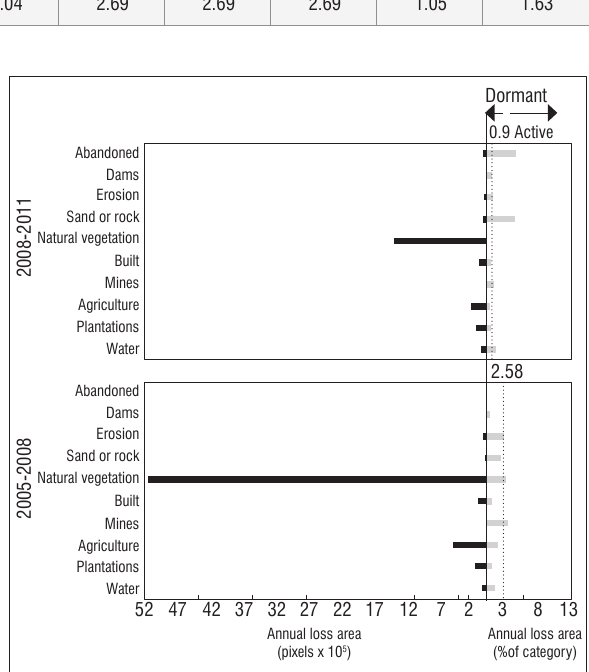
0.25 0.06 Dams 0.15 0.01